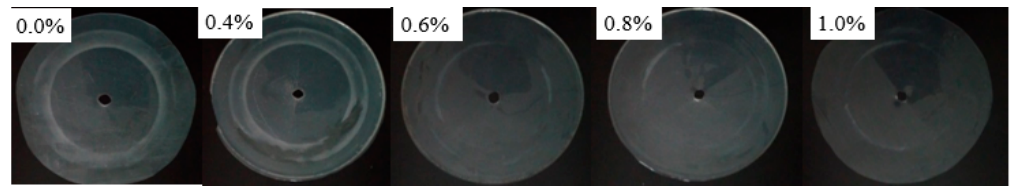
Figure 11. Stand wears and tears of SGO/WPU composites with different SGO contents.